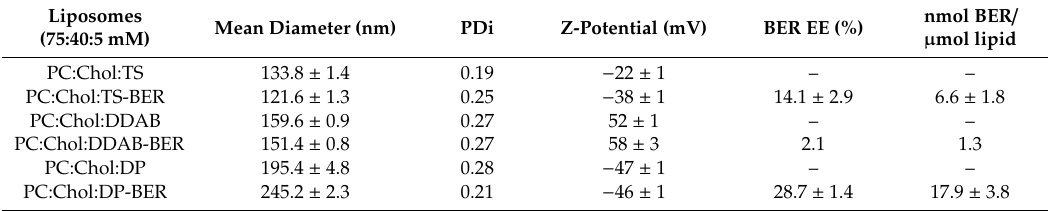
Table 2. Physicochemical properties of blank and berberine (BER)-containing